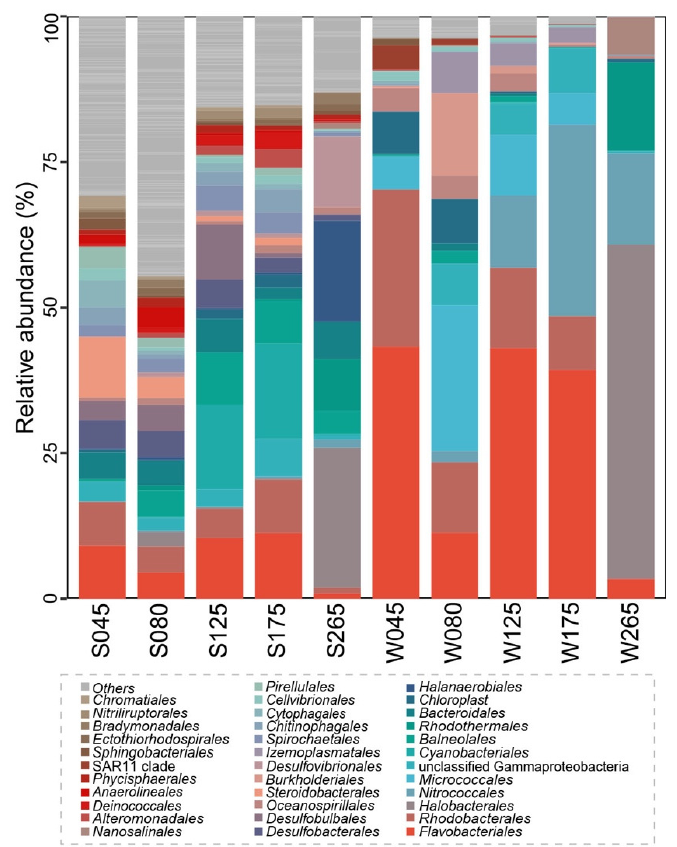
Figure 2. Prokaryotic community composition indicating the most abundant orders along a gradient of increasing salinity. The top 35 most abundant order taxa are shown. The labels S and W represent sediment and water samples, respectively. The number in each sample means